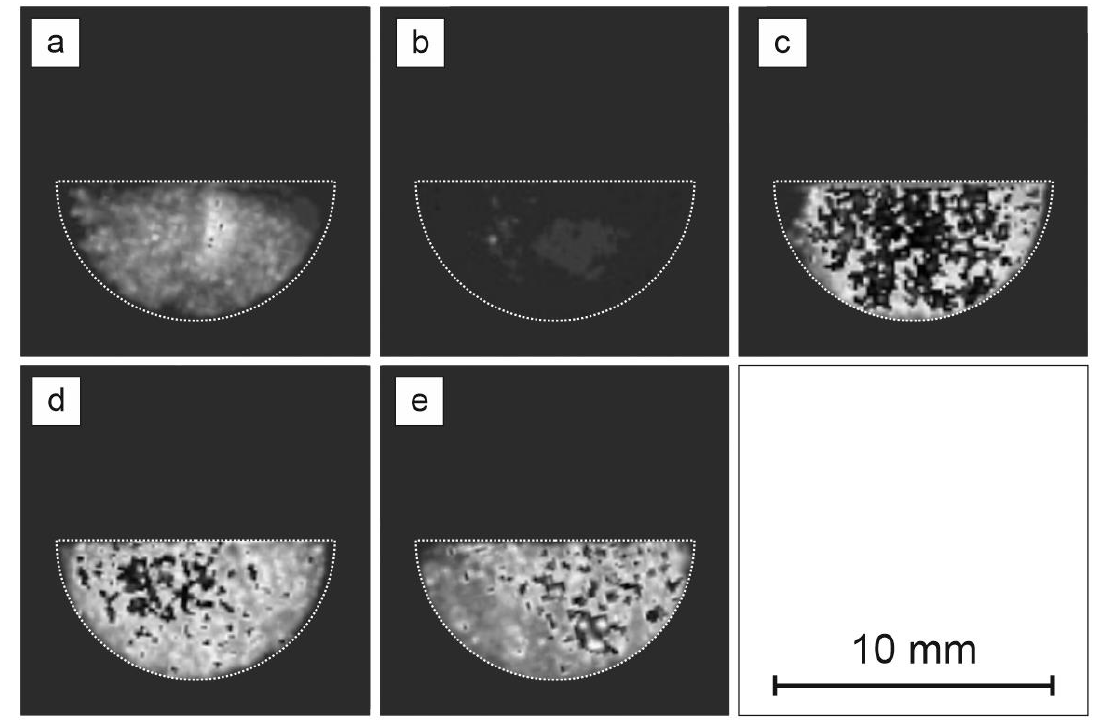
Figure 6. Photoluminescence images of Egyptian blue after different dispersion operations ( a ) reference powder, ( b ) 15 days of exfoliation (I), ( c ) horizontal bead mill (II), ( d ) three-roll mill (III) with medium M1, ( e ) three-roll mill (III) with medium M2. XRD measurements detected two significant phases in the form of cuprorivaite and cristobalite. The X-ray phase analysis was performed using the HighScore Plus program and the COD crystallographic database. Figure 7 presents the XRD pattern of Egyptian blue after horizontal bead mill treatment.